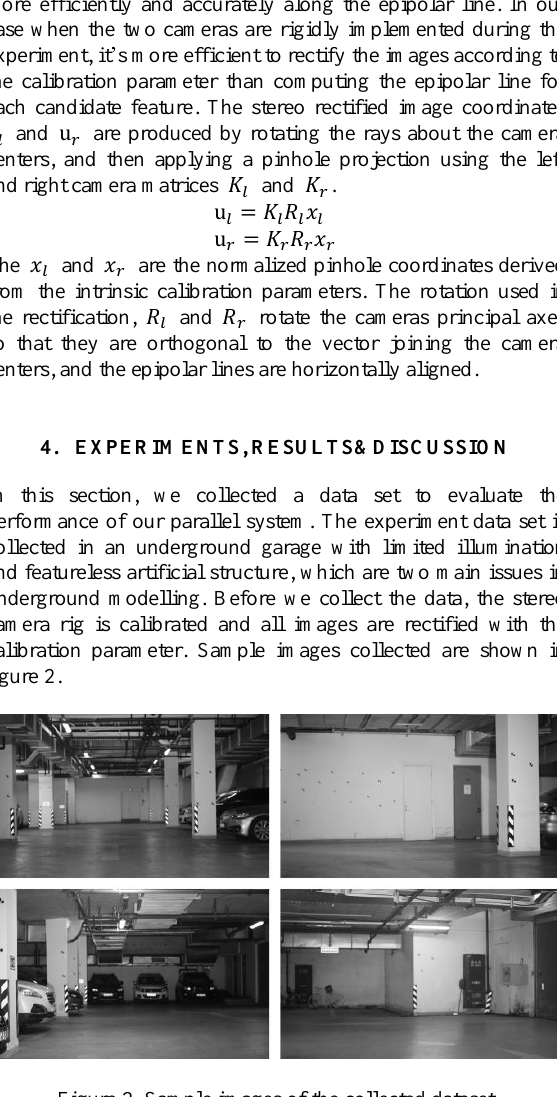
Figure 2. Sample images of the collected